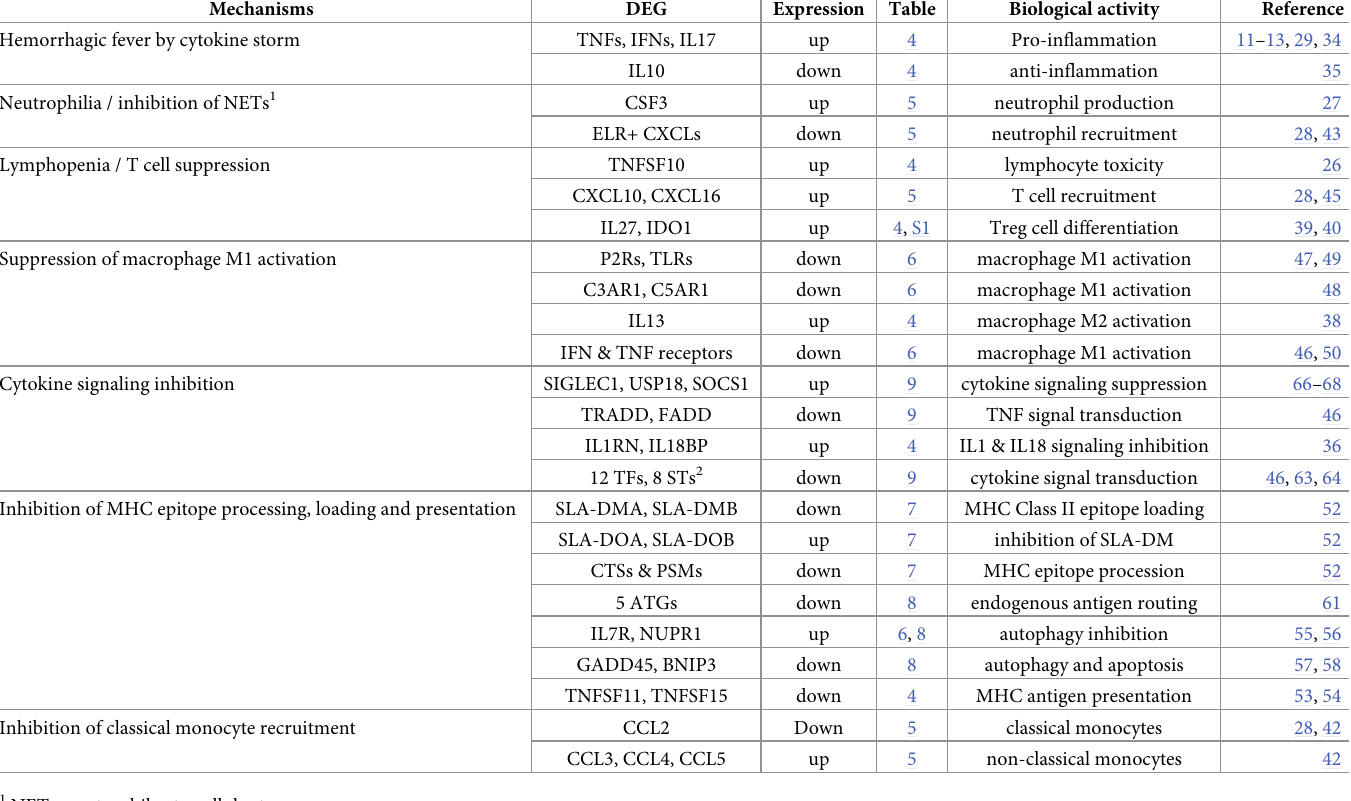
Mechanisms DEG Expression Table Biological activity